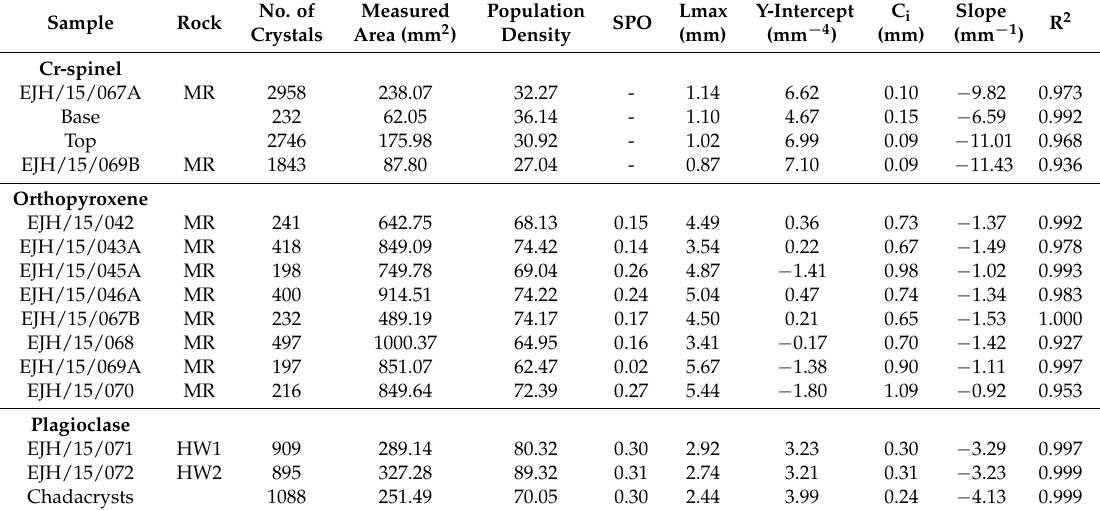
Table 1. Crystal size distribution (CSD) input and output data. SPO = shape preferred orientation of crystal long axes from 0 (no alignment) to 1 (perfect alignment). Lmax = mean size of the four largest crystals. Y-intercept = y -axis intercept of linear regression. C i (characteristic length) = − 1/slope. Slope = gradient of linear